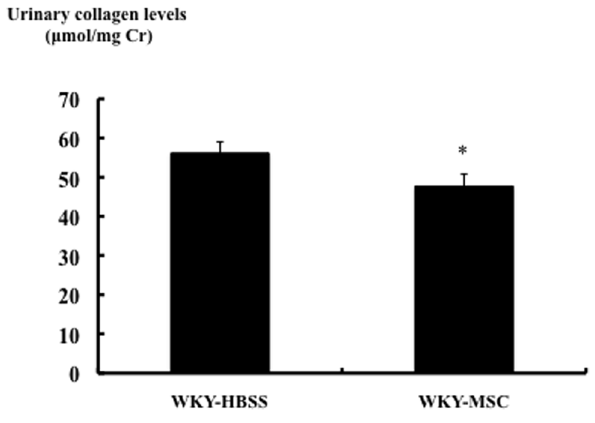
Figure 6. Effects of MSCs on urinary collagen levels in the study groups. Urinary collagen levels of each group measured as described in materials and methods. Data are expressed as means 6 SEM. Mann-Whitney test: *p , 0.05; HBSS-treated rats with nephritis vs. MSC-treated rats with nephritis.